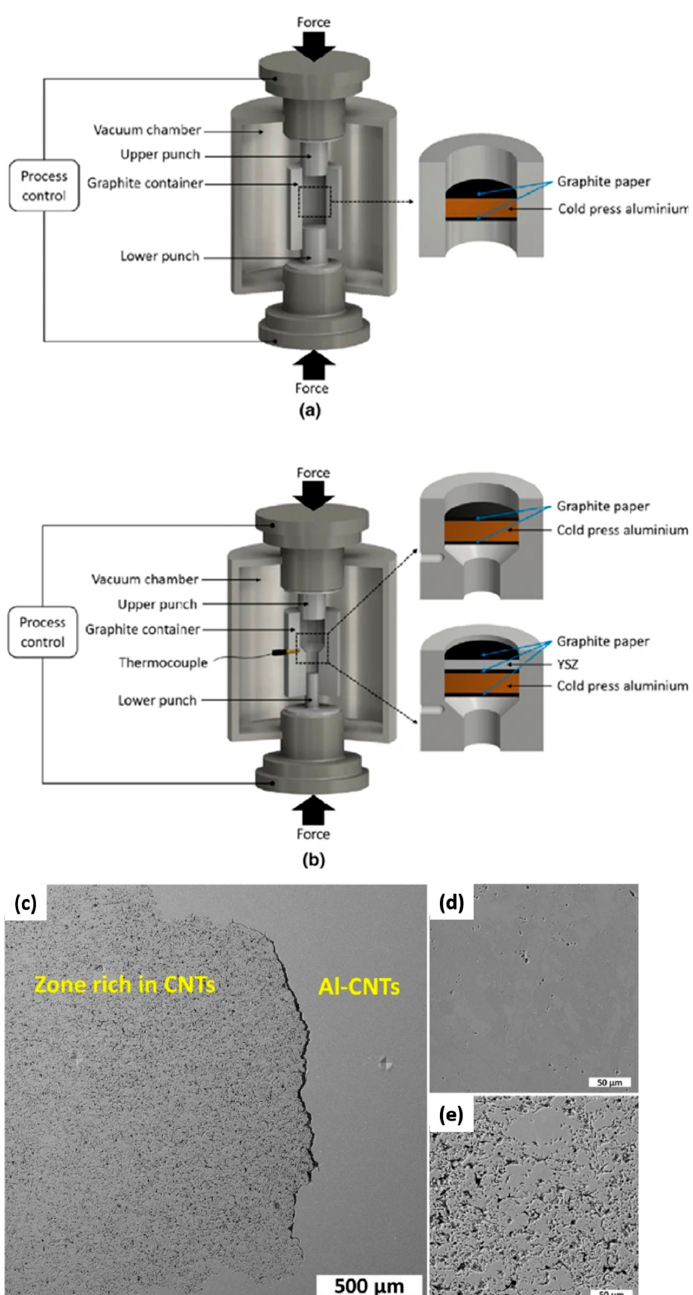
Figure 13. Schematic of the graphite die used for ( a ) cold pressing the Al-CNT green body, and ( b ) position of the sample before the spark plasma extrusion process. The microstructure of the Al-CNT composite produced by SPE process ( c ) interface of Al and CNT, ( d ) Al-rich region next to the interface, and ( e ) CNT-rich region. Reproduced with permission from reference [92].